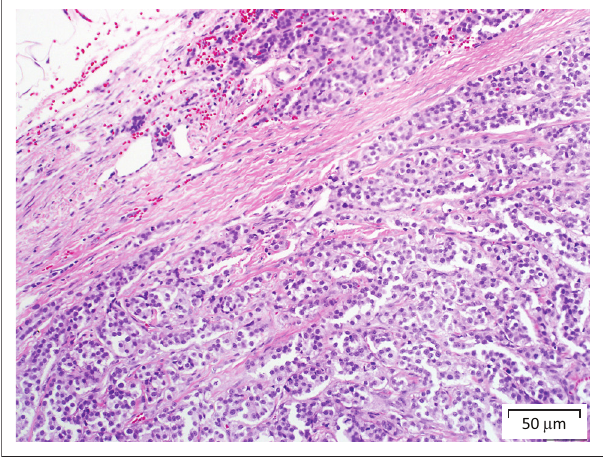
FIGURE 1: Renal paraganglioma. Partially encapsulated, multi-lobulated tumour mass consisting of packets of monotypic round to polygonal tumour cells separated by a thin fibrovascular stroma.